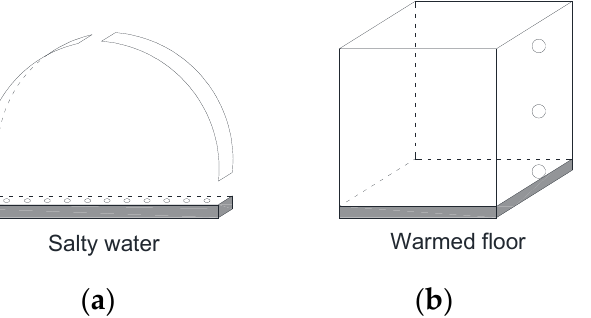
Figure 9. ( a ) The greenhouse model used in the study of Oca et al. [45], ( b ) the ventilation model applied by Gladstone and Woods [48].